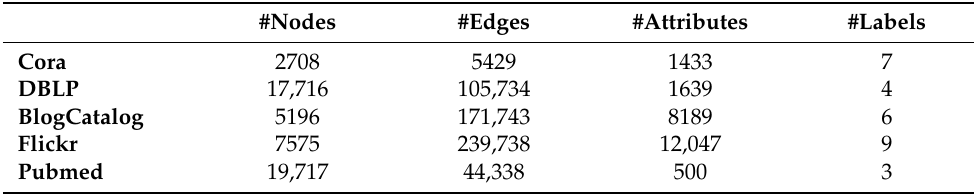
Table 2. Statistics of the datasets used in the